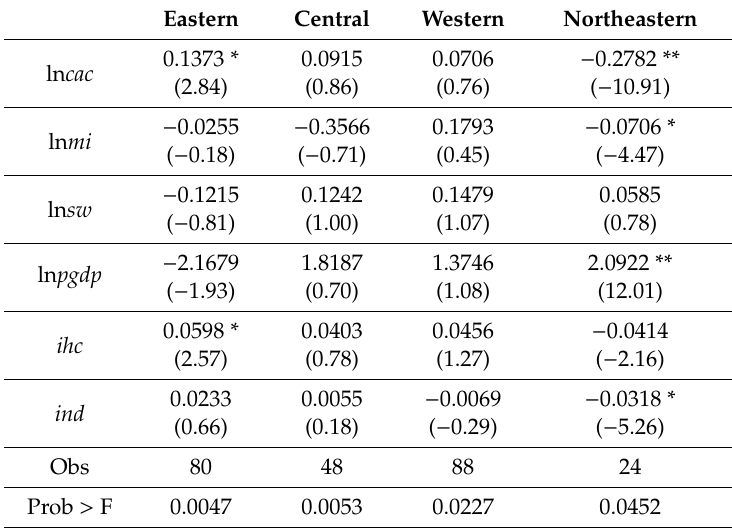
Table 6. Sub-regional estimation results of the impact of di ff erent environmental policy instruments on green technology